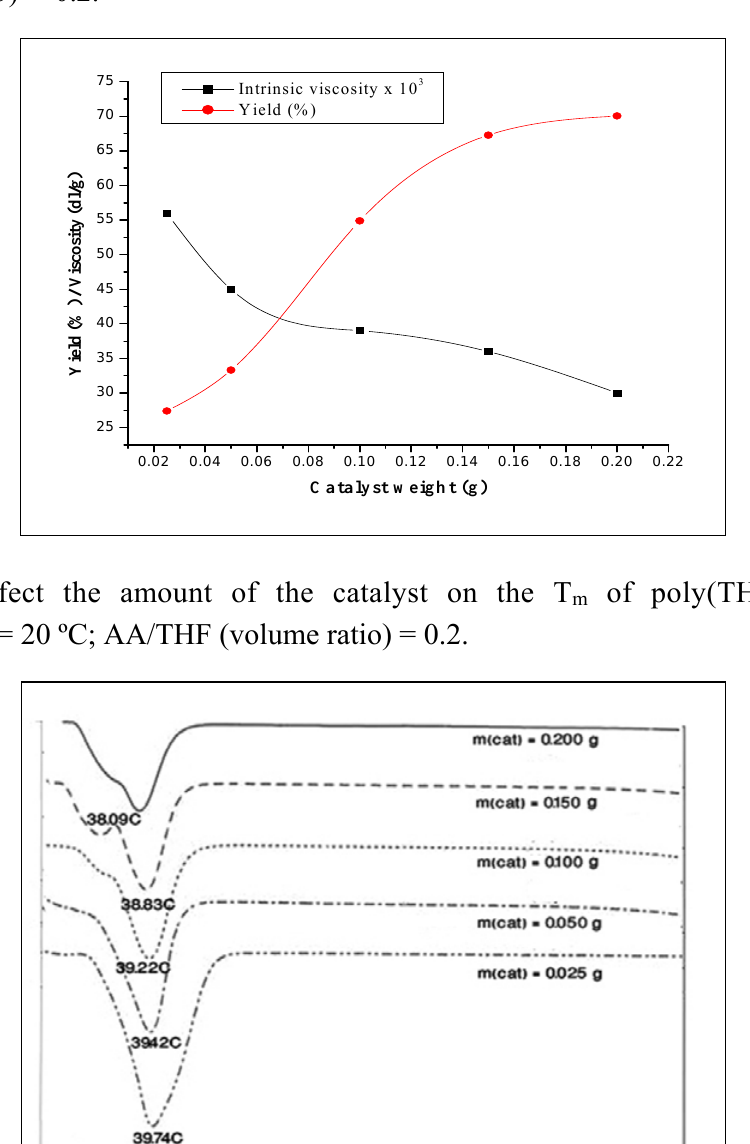
Figure 5. Effect of the amount of the catalyst on the conversion and on the intrinsic viscosity of the Poly(THF). Reaction conditions: T = 20 ºC; AA/THF (volume ratio) = 0.2.